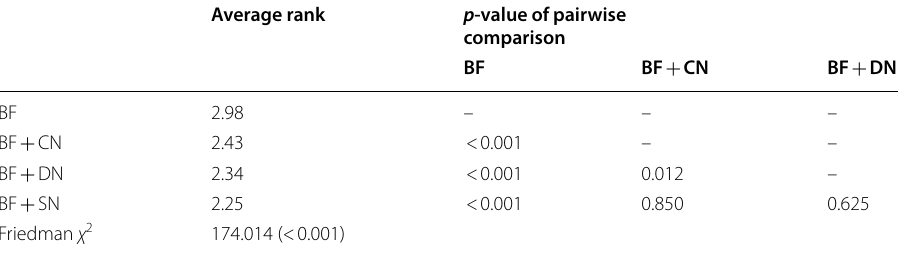
CN, BF DN, and BF + +